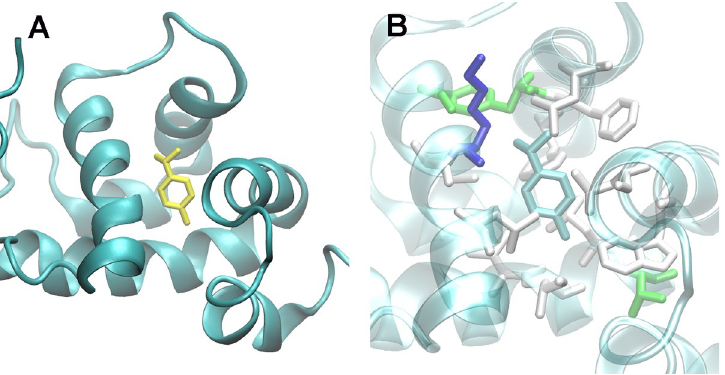
Fig 5. Docking of p -cymene inside a CSP. A. Best binding mode of p -cymene (yellow) within AAEL001999 protein (ribbon representation). B. Zoom of the binding cavity, highlighting as solid colored sticks all amino acid sidechains within 5 Å of the